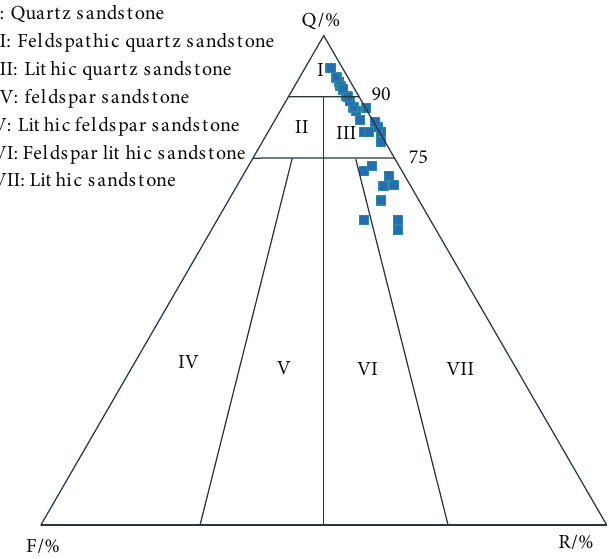
Figure 3: Reservoir petrology types of Shan 1 in Yanchang area. Table 1: Mineral content of Shan 1 reservoir in Yanchang